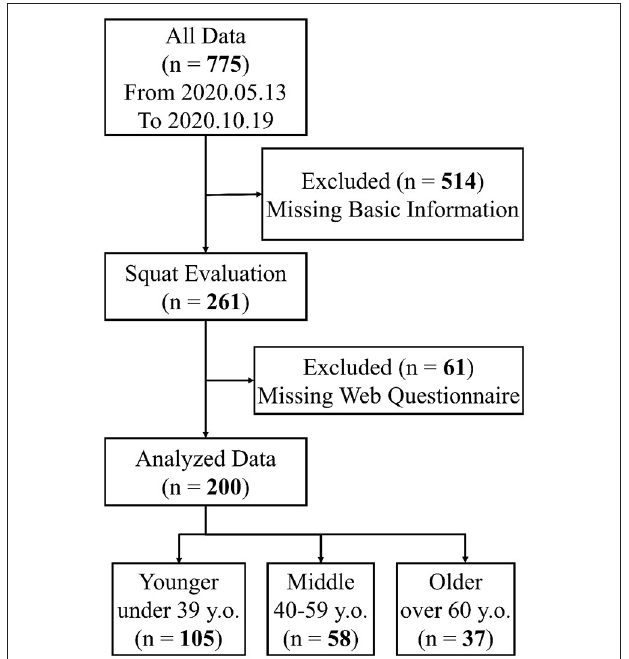
FIGURE 5 | Flow chart of data